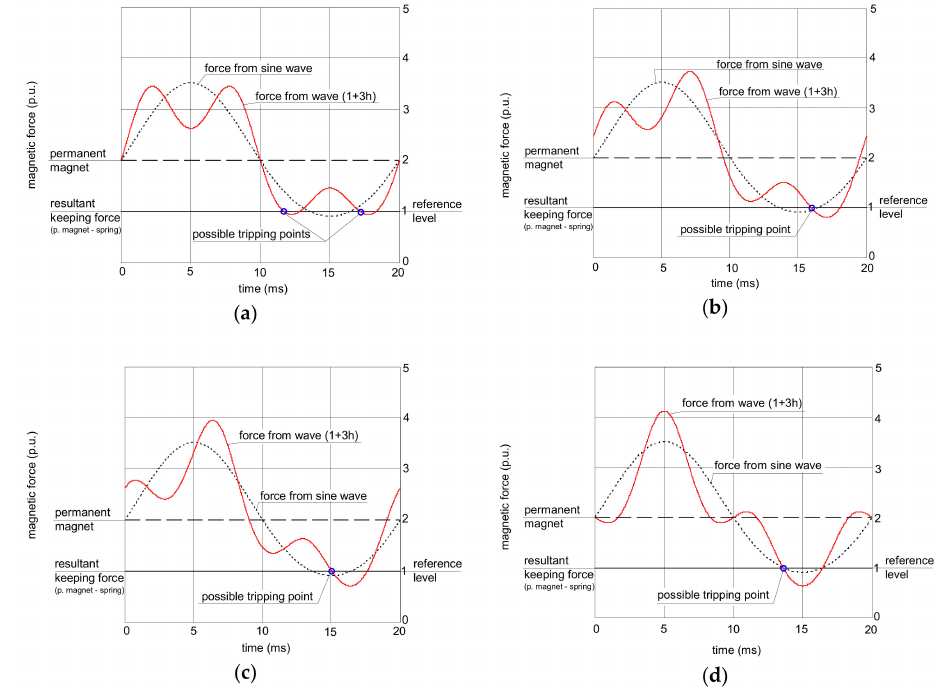
Figure 4. Interaction between forces in the electromechanical relay of the RCD for earth fault current waveforms comprising the fundamental and 50% of the 3 rd harmonic. Phase angle of the 3 rd harmonic: ( a ) 0 ◦ ; ( b ) 45 ◦ ; ( c ) 90 ◦ ; ( d ) 180 ◦